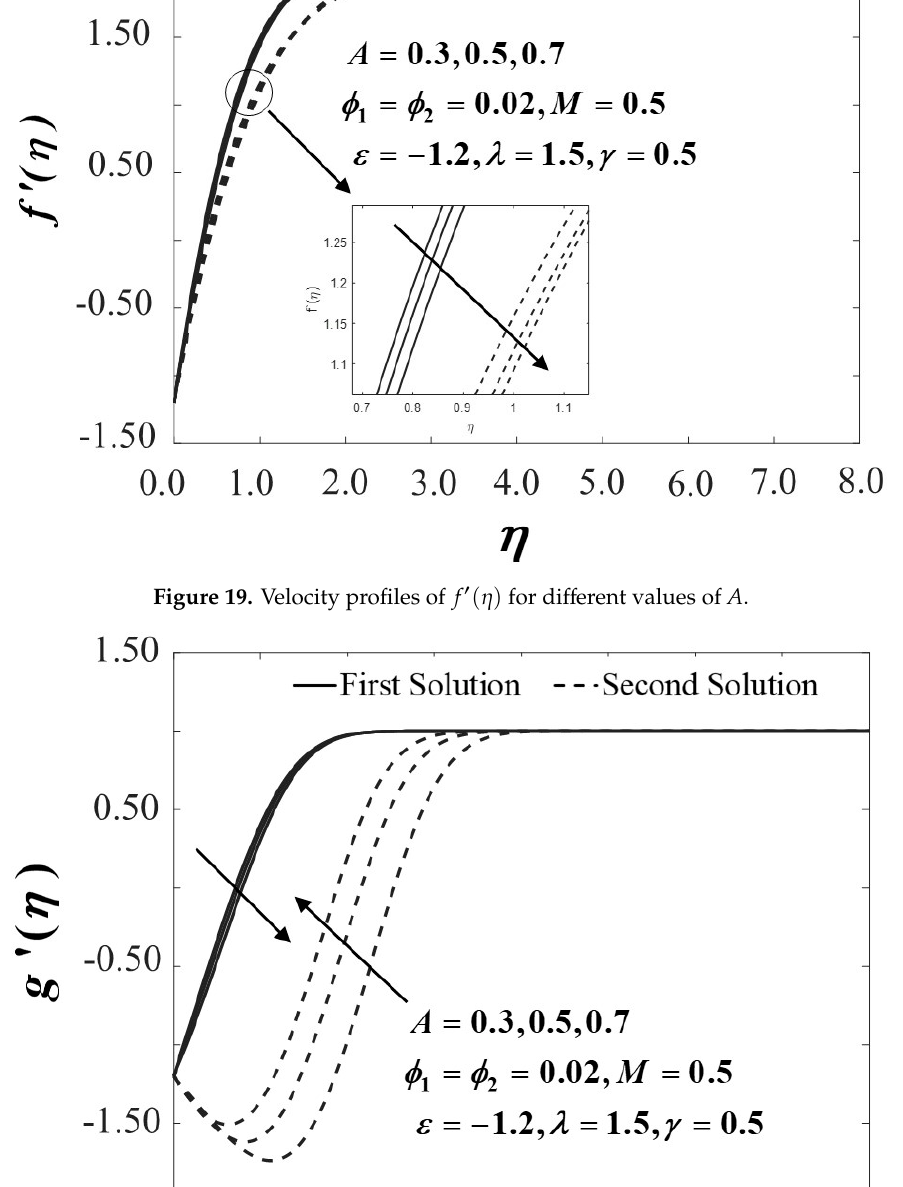
Figure 20. Velocity profiles of g (cid:48) ( η ) for di ff erent values of A